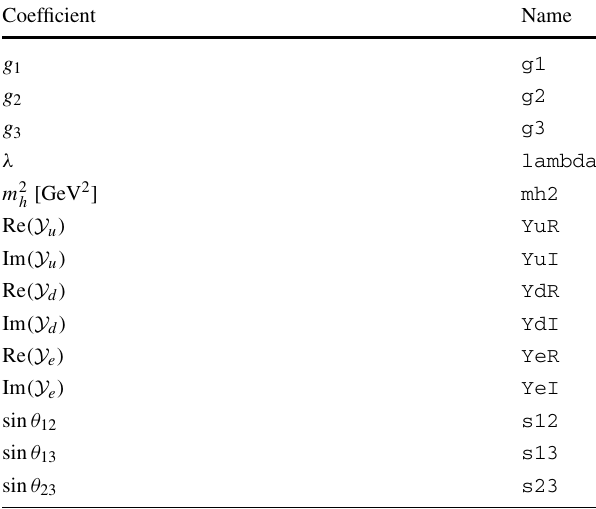
Table 5 Standard Model parameters in RGESolver . The last 3 labels of this table must be used with the GetCKMAngle method. All the others must be used with the GetCoefficient method